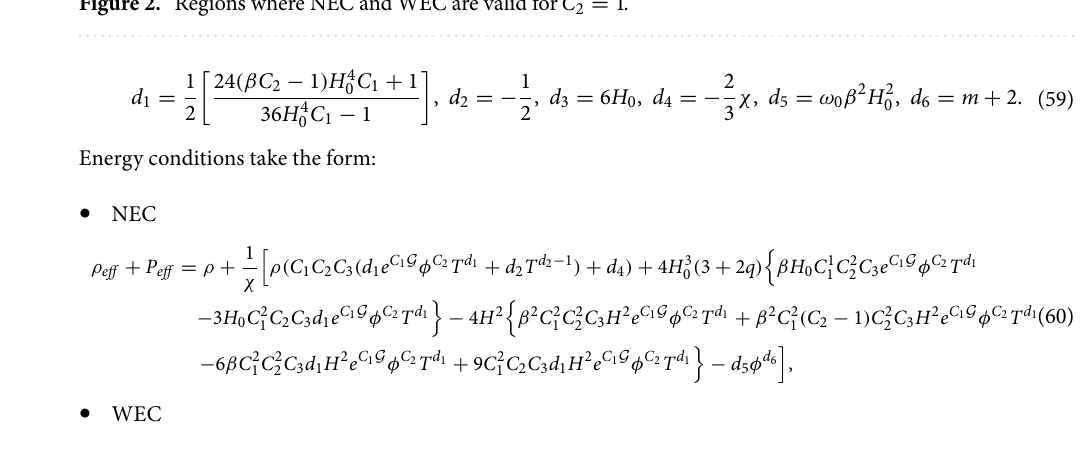
Figure 2. Regions where NEC and WEC are valid for C 2